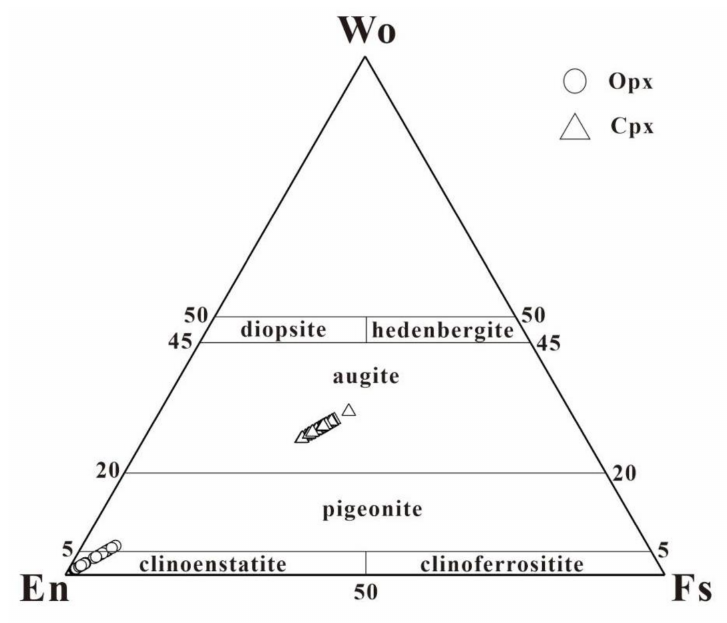
Figure 7. Wo-En-FS diagram of the orthopyroxene (Opx) and clinopyroxene (Cpx) in the websterite (modified after Morimoto [44]).